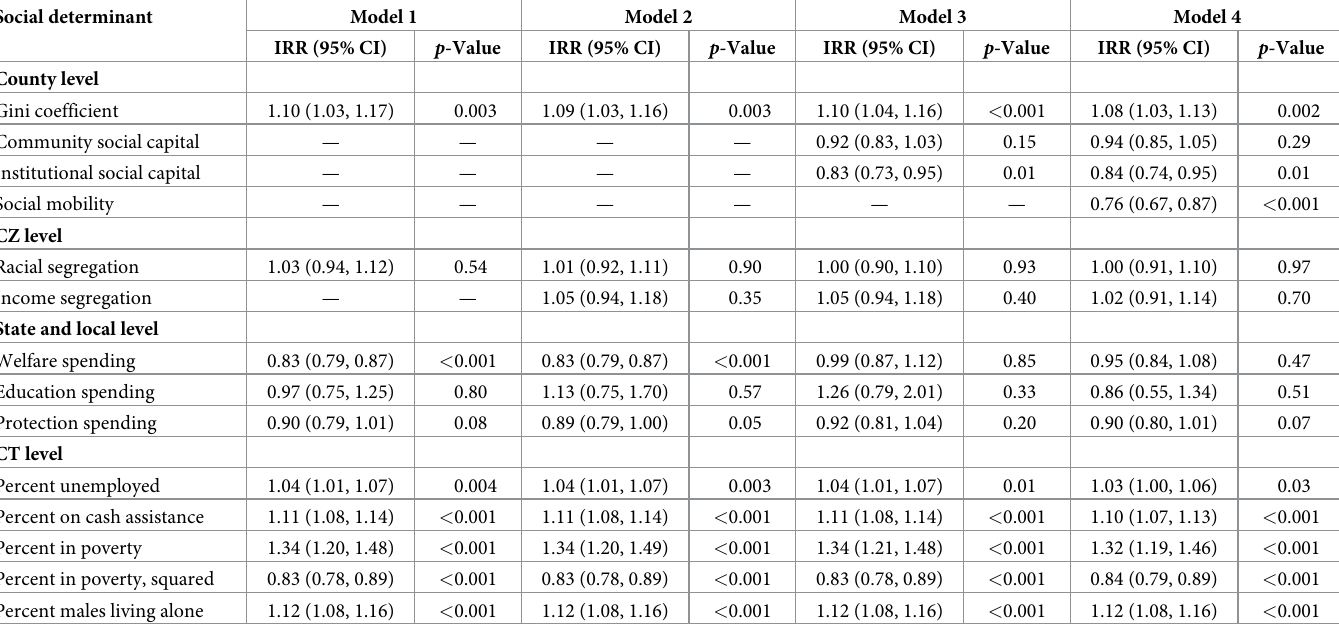
Table 2. Social determinants and the total number of firearm-related homicide incidents at the CT level in the contiguous US,